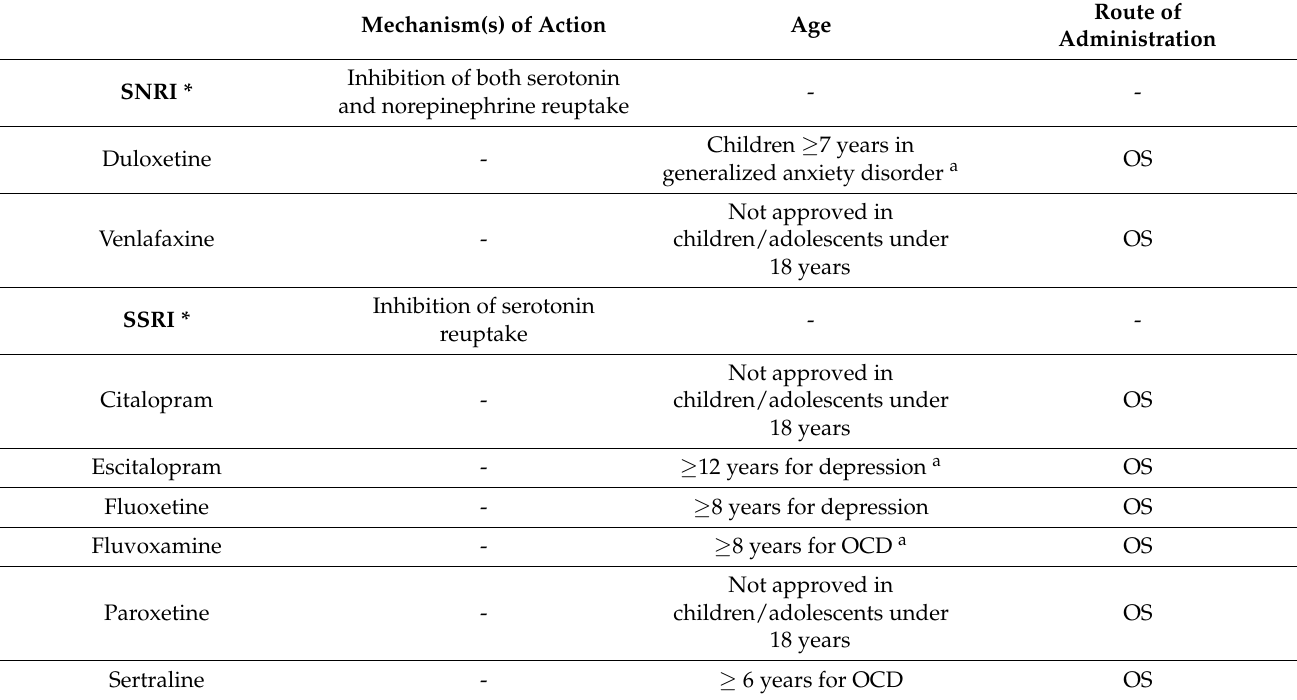
Table 4. SSRI and SNRI antidepressants (no clinical trials available for PPPD). Mechanism(s) of Action Age